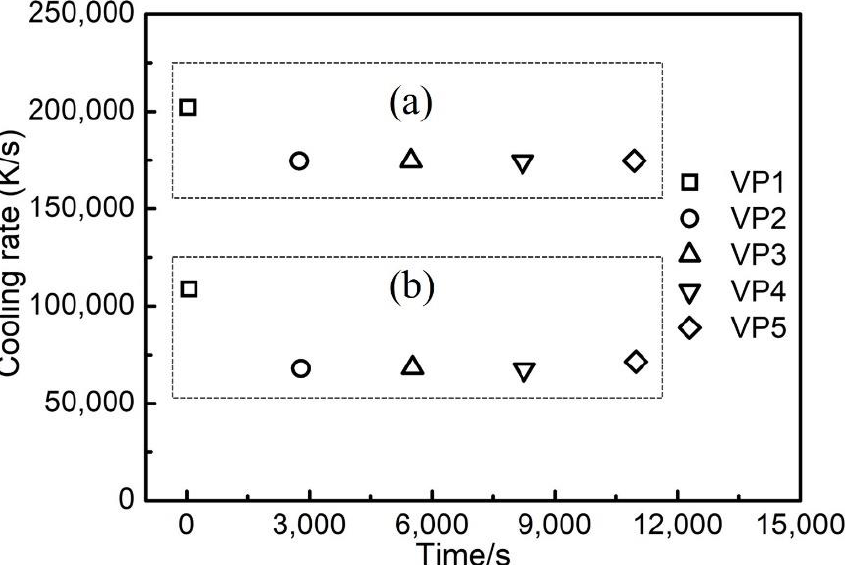
Figure 5. Maximum cooling rate at the five vertical sampling points: ( a ) at the end of the melting process of the layer in question, ( b ) resulting from the thermal processes of subsequent layers.